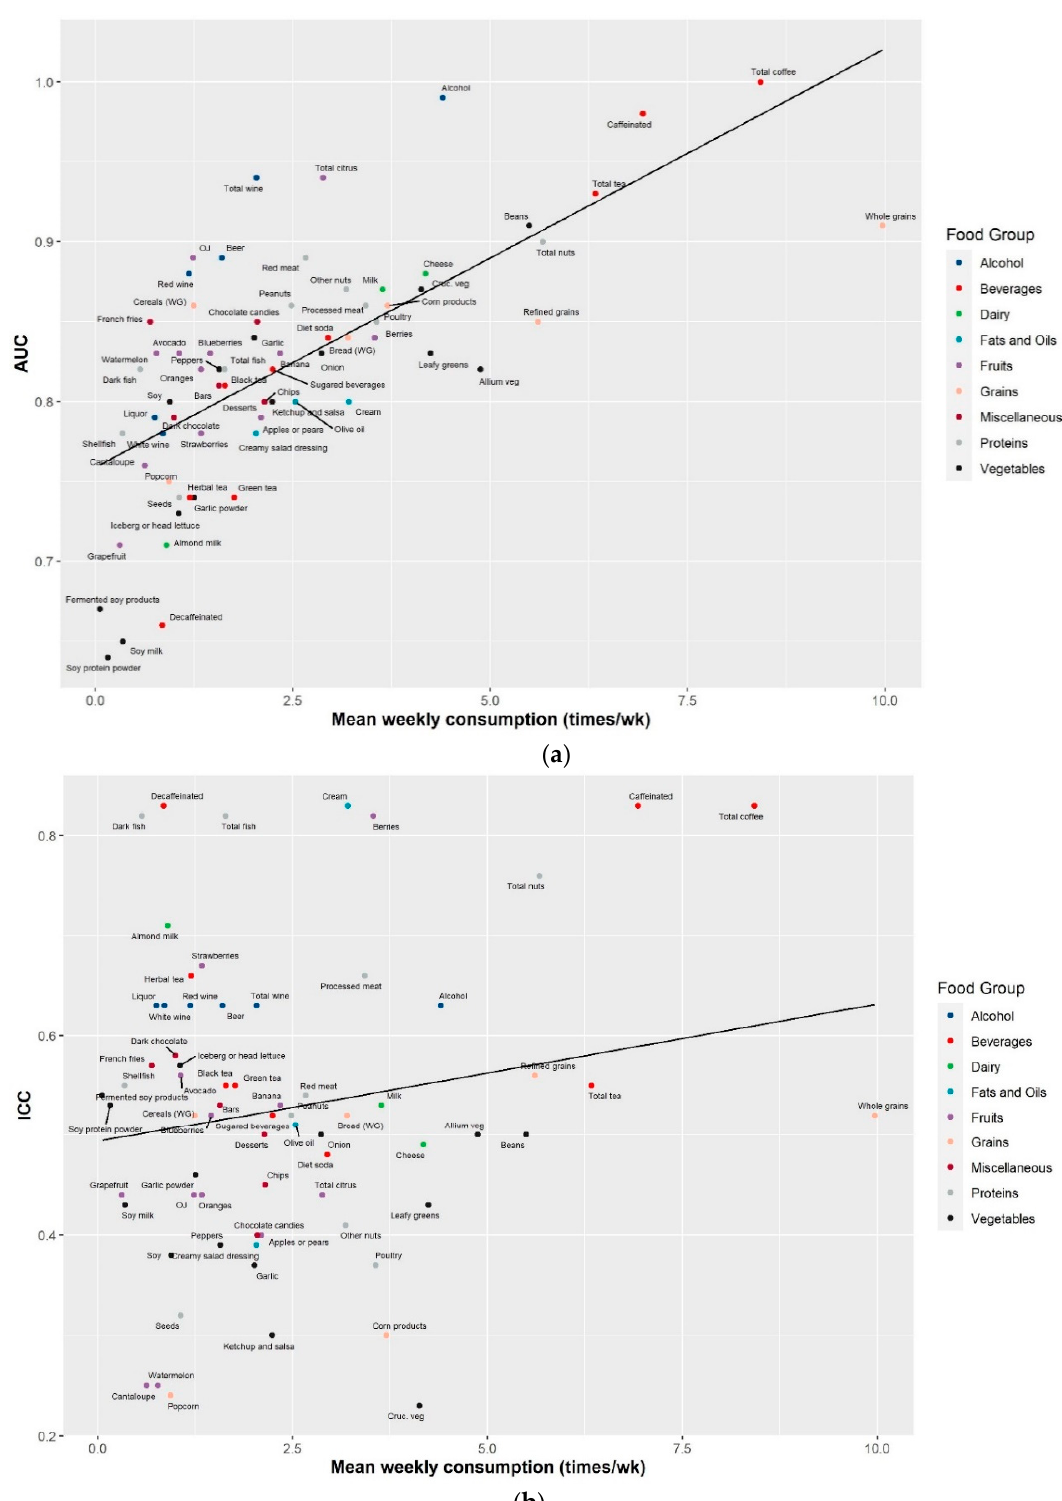
Figure 2. Metabolite prediction accuracy and reproducibility by food consumption frequency for the most predictive metabolite of 71 food groups/items assessed using the FFQ in the Cancer Prevention Study-3 Diet Assessment Sub-study. ( a ) Metabolite prediction accuracy, assessed by area under the curve (AUC) from the receiver operating characteristic curve, in relation to food consumption frequency; ( b ) metabolite reproducibility, assessed by intraclass correlation coefficients (ICCs) over six months, in relation to food consumption